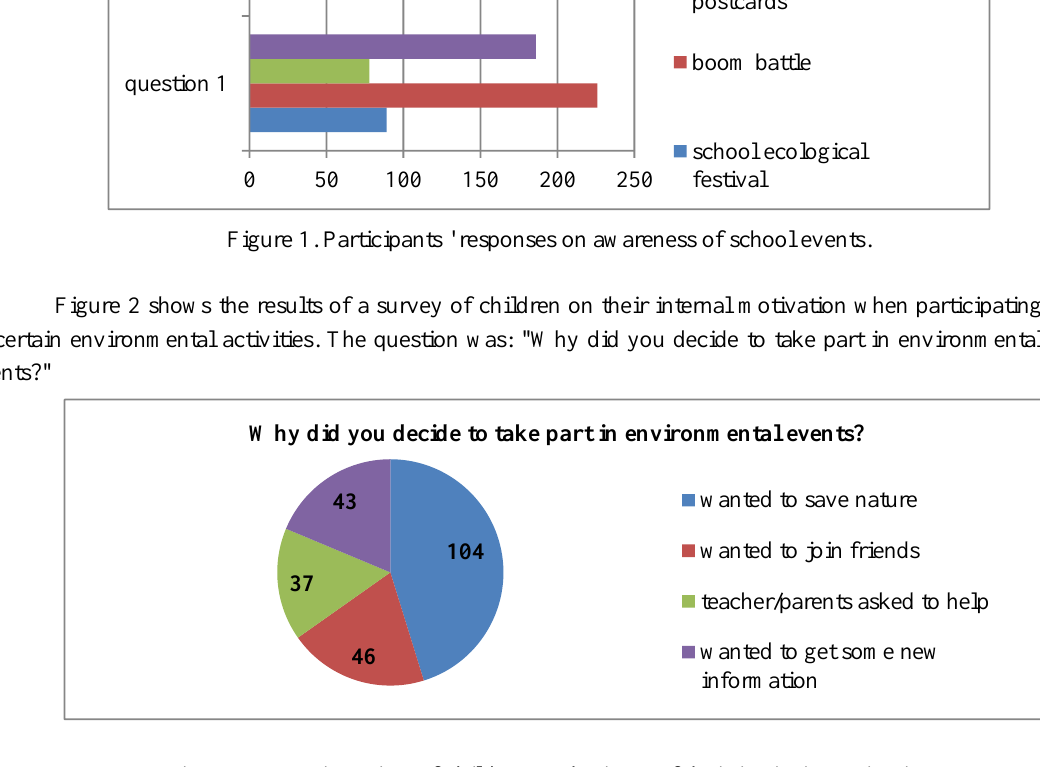
Figure 2. Questionnaires of children on the issue of their intrinsic